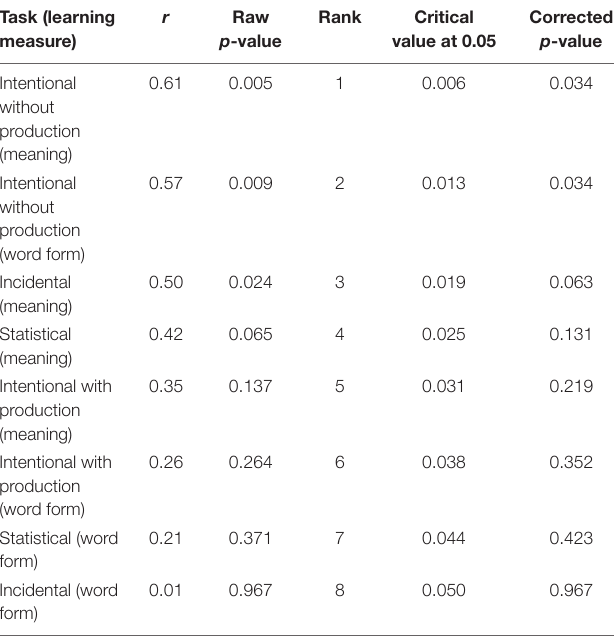
TABLE 4 | Correlations between age and learning performance with critical values of the Benjamini–Hochberg correction at an FDR of 0.05 and corrected p -values. Task (learning